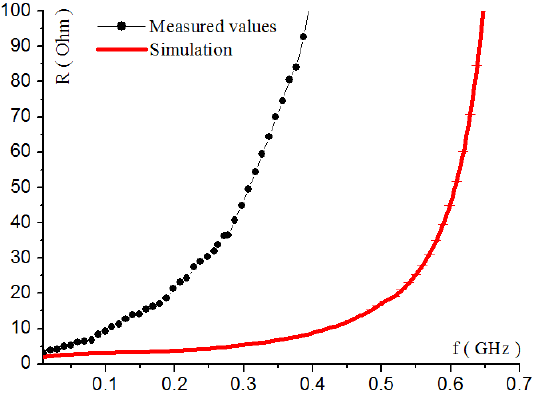
Figure 9: Resistance of the spiral inductor versus